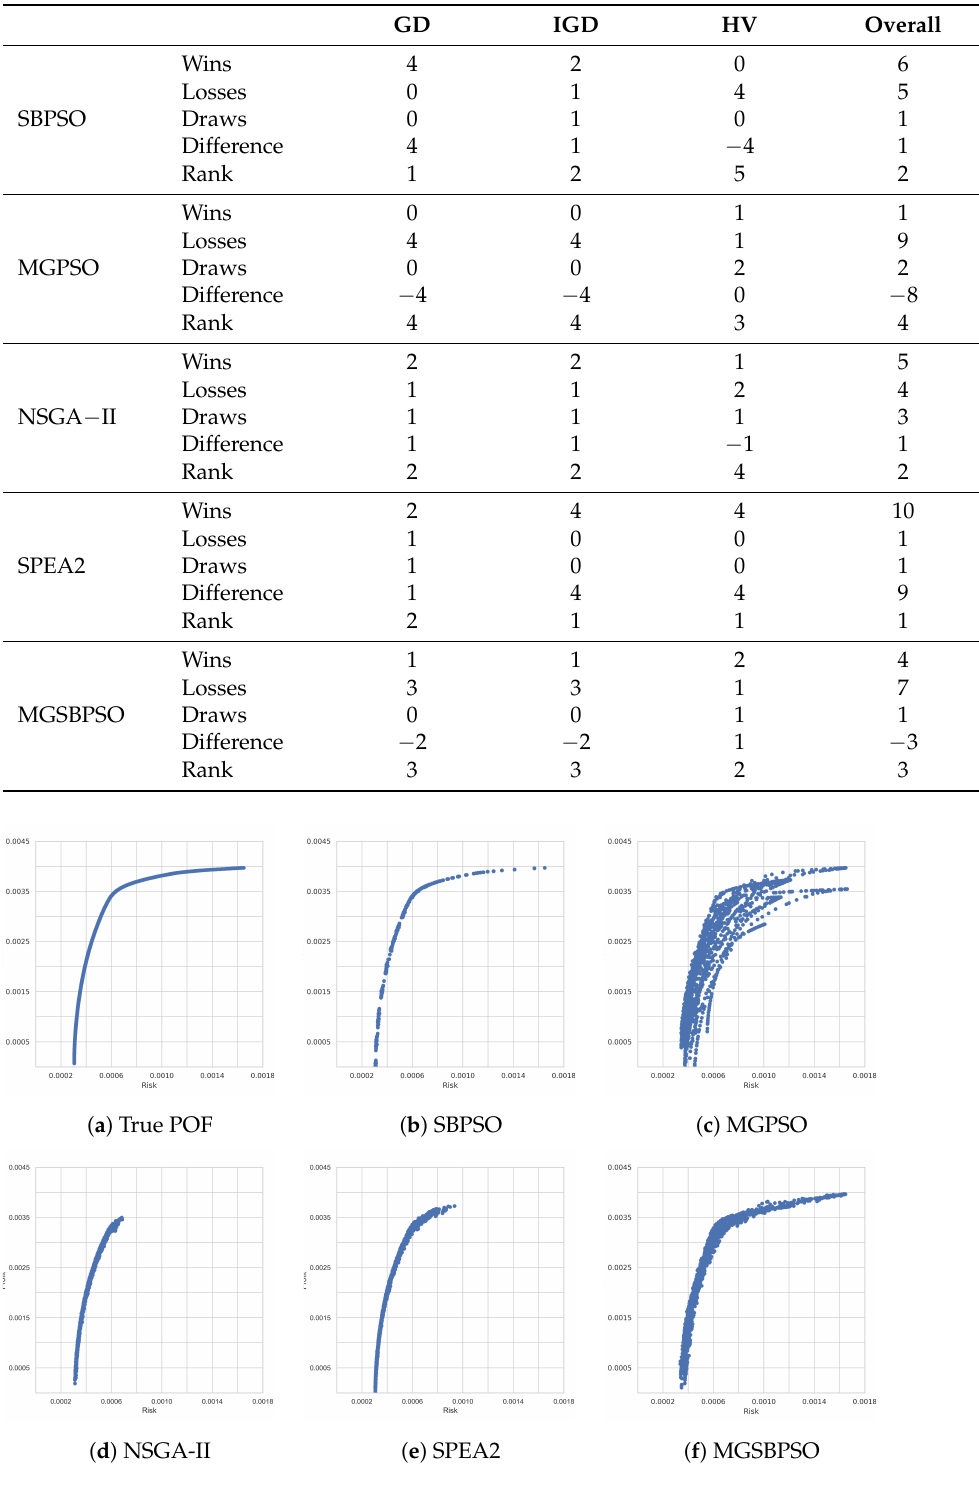
Table 14. Nikkei 225 rankings for each performance measure.